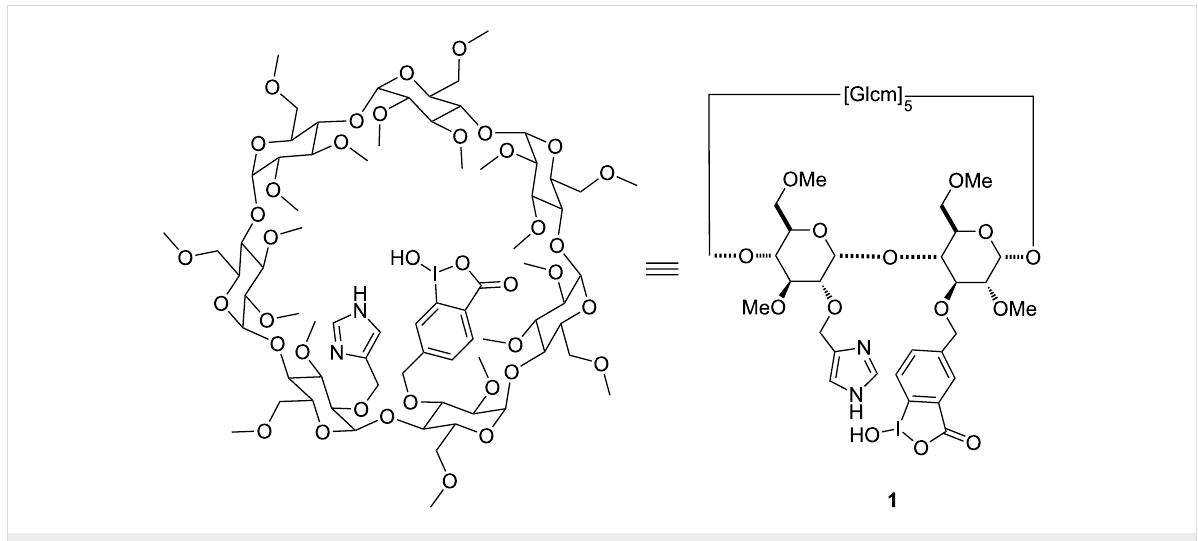
Figure 2: Scavenger based on a heterodifunctionalized β -cyclodextrin derivative.